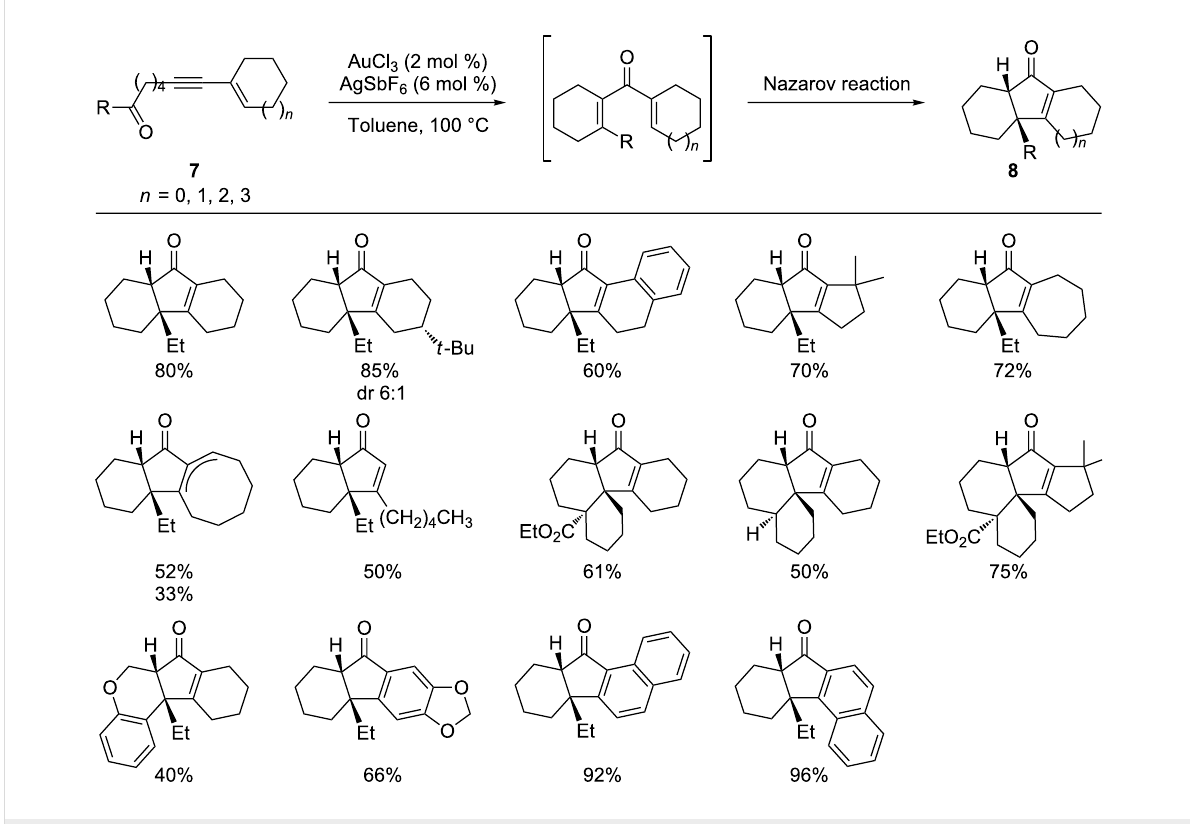
Scheme 5: Gold-catalyzed tandem oxygen transfer/Nazarov cyclizations.